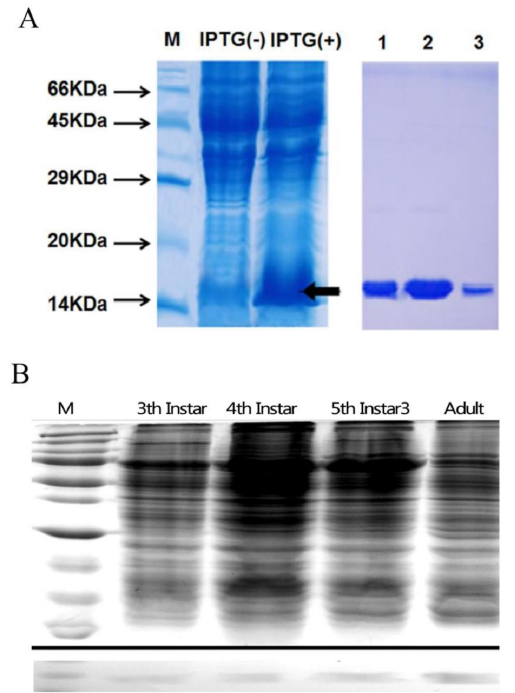
Figure 2. ( A ) Expression and purification of recombinant Lmig CSPIII, as analyzed by SDS-PAGE. (Left panel) M, protein molecular weight marker from the top: 66, 45, 29, 20, and 15 KDa. IPTG ( − ), bacterial cells before IPTG induction. IPTG (+), bacterial cells after IPTG induction. A black arrow indicates the target recombinant protein. (Right panel) Purified recombinant protein with the expected molecular weight of approximately 14 kDa. Proteins were mostly expressed in the supernatant; affinity chromatography was used for purification. The numbers denote the last three fractions of the purification step. ( B ) Western blotting results. Upper, SDS-PAGE of the locust antenna proteins; Lower, corresponding Western blot. Antiserum against LmigCSPIII cross-reacted with locust antenna protein at different developmental stages. M, standard protein marker; 3, 4, 5, 6, as in